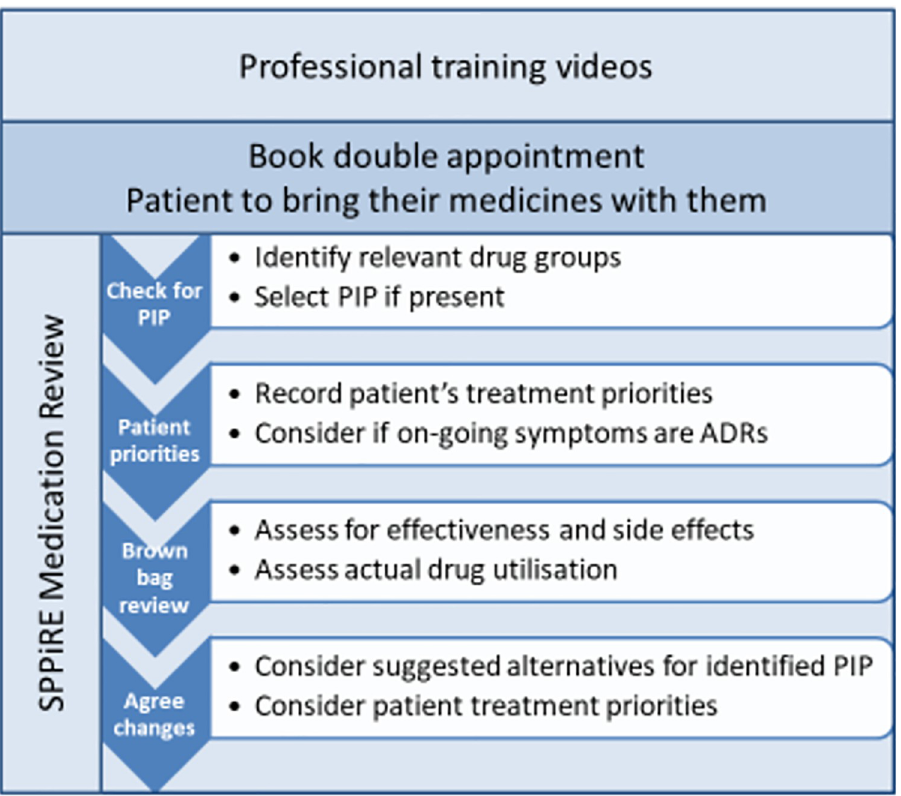
Fig 1. SPPiRE intervention. A AU : AbbreviationlistshavebeencompiledforthoseusedthroughoutFigs 1 and 2 : Pleaseverifythatallentriesarecorrect : DR, adverse drug reaction; GP, general practitioner; PIP, potentially inappropriate prescribing; SPPiRE, Supporting Prescribing in Older Adults with Multimorbidity in Irish Primary Care.